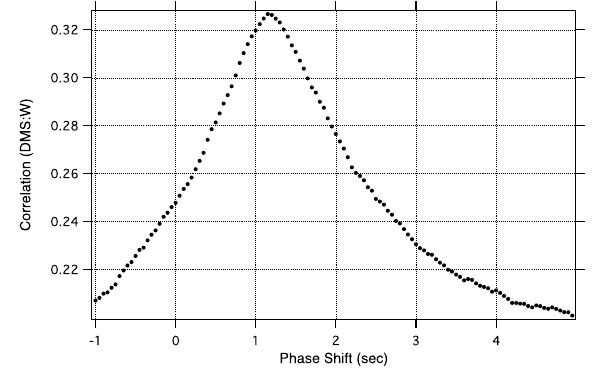
Fig. 3. Lag correlation between DMS and w . The peak in cor- relation shows the DMS signal is lagged by 1.15s with respect to vertical wind velocity.